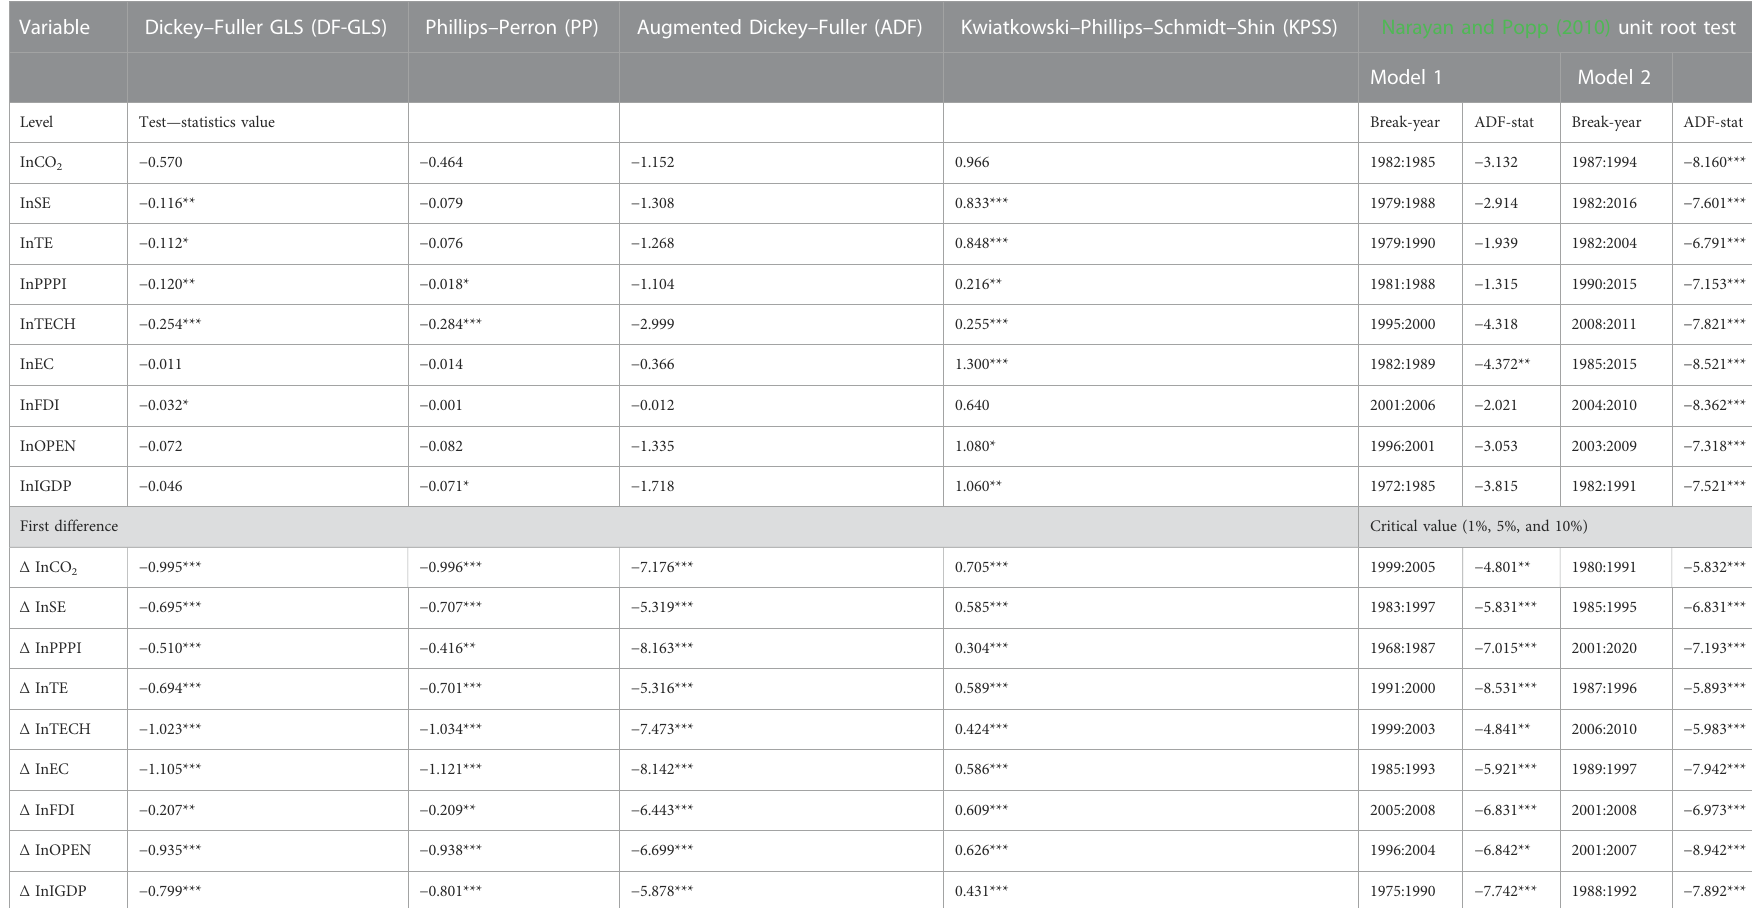
TABLE 4 Unit root